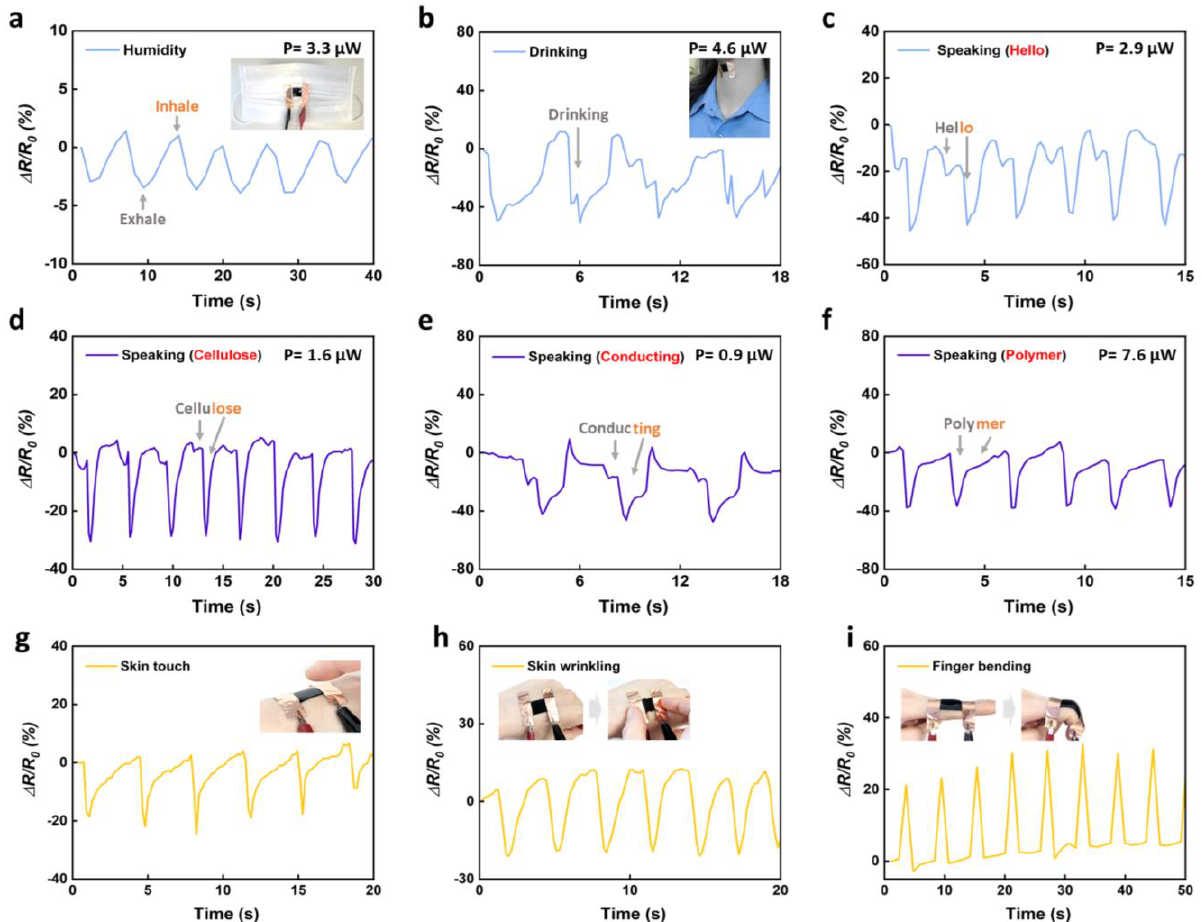
Figure 4. Response curves of on-skin sensors based on CMC-PEDOT:PSS film for ( a ) respiratory humidity, ( b ) drinking, and speaking the words ( c ) hello, ( d ) cellulose, ( e ) conducting, and ( f ) polymer. Changes in relative resistances of sensors monitoring human movements of ( g ) skin touch, ( h ) skin wrinkling, and ( i ) finger bending.